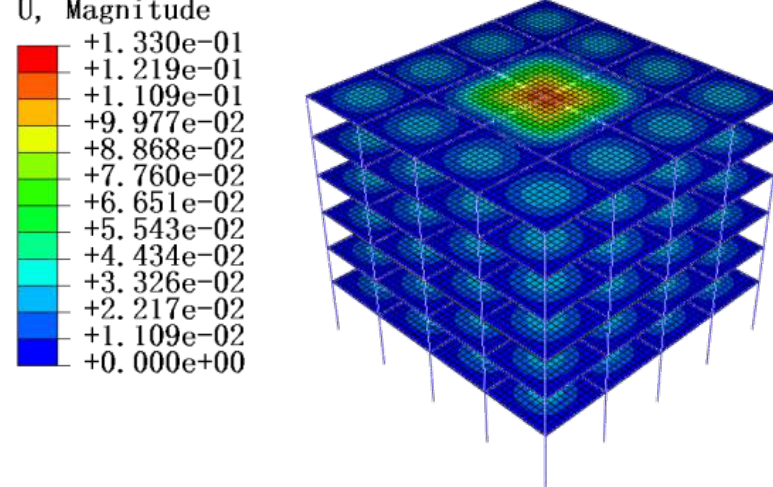
Figure 12. The most unfavorable combination displacement diagram of the bottom inner column .